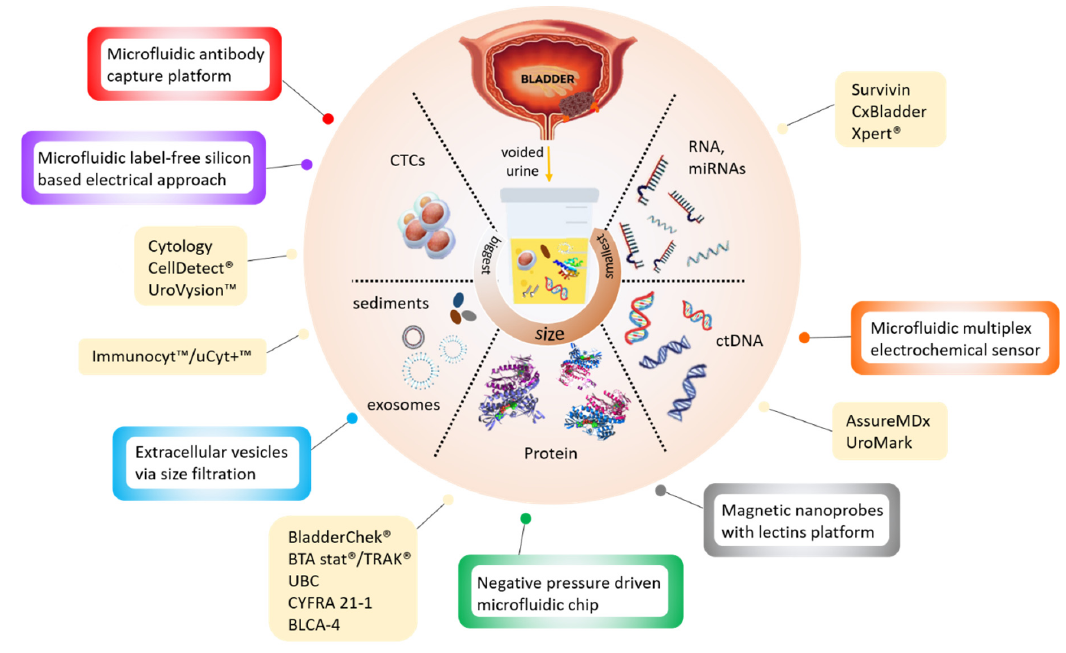
Figure 1. Infographic illustrating the currently available (yellow boxes) and potential microdevices (colour bordered boxes) for urinary bladder cancer diagnosis, as described in Tables 1 and 2 below.